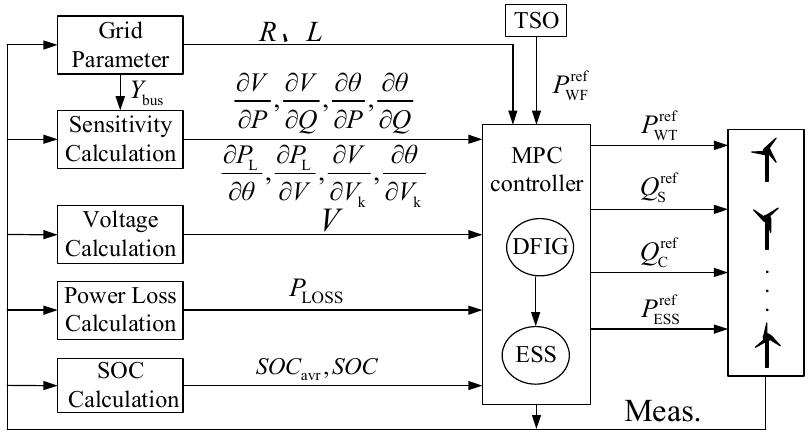
Figure 2. Structure of control scheme.